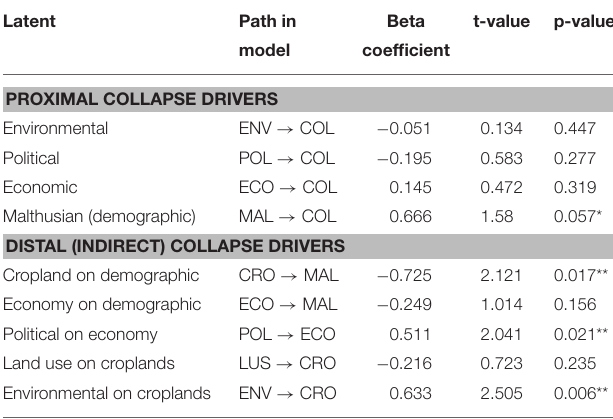
TABLE 2 | Structural